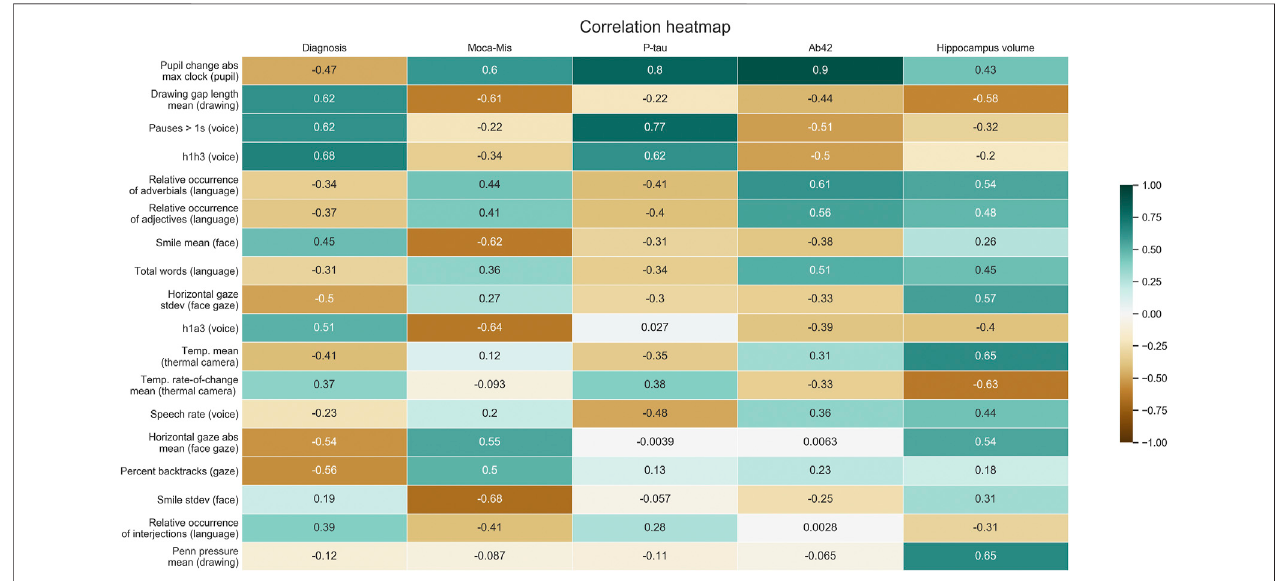
FIGURE 6 | Summary of correlations between selected digital biomarker candidate metrics and clinical assessment measures.